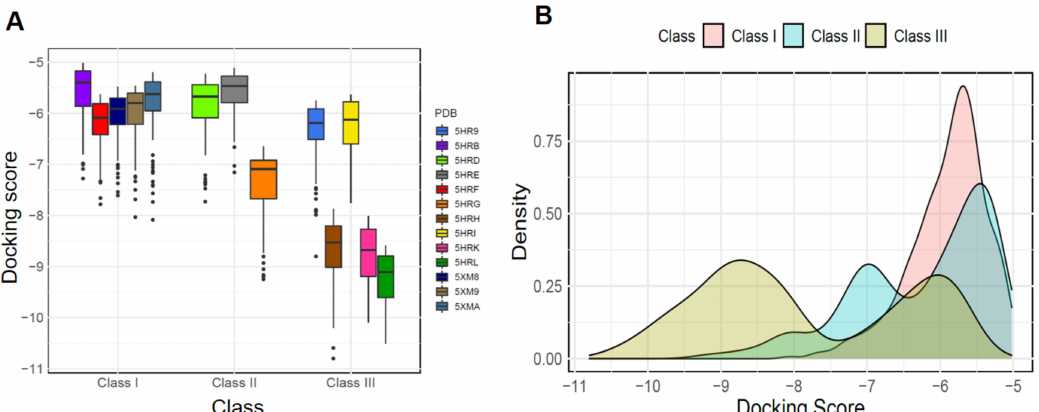
Figure 4. Comparison of the docking performance of three classes across the Asfv PolX dataset. ( A ) Boxplots for Glide docking score distributions of each crystal structure. The black line indicates the median result for each crystal structure. ( B ) The probability density curves of Glide docking score. The X-axis represents the docking score of each structure-ligand pair, and the Y-axis represents the probability